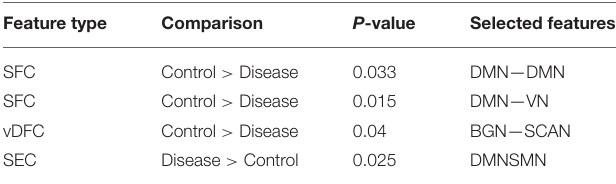
TABLE 17 | Network-to-network interactions selected by enrichment analysis for ASD dataset. Feature type